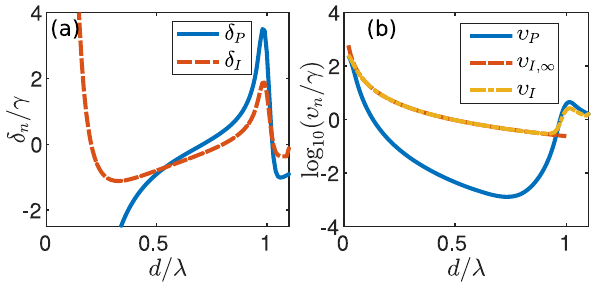
Figure 1: Collective excitation eigenmode (a) line shifts and (b) (log- scale) linewidths of the uniform mode with dipoles pointing out-of- plane ( δ P , υ P ) and in-plane ( δ I , υ I ) for a 20 × 20 lattice. υ I , ∞ is the N → ∞ analytic formula [Equation (10)] for υ I . Resonance level shifts are equal for d ≈ 0.54